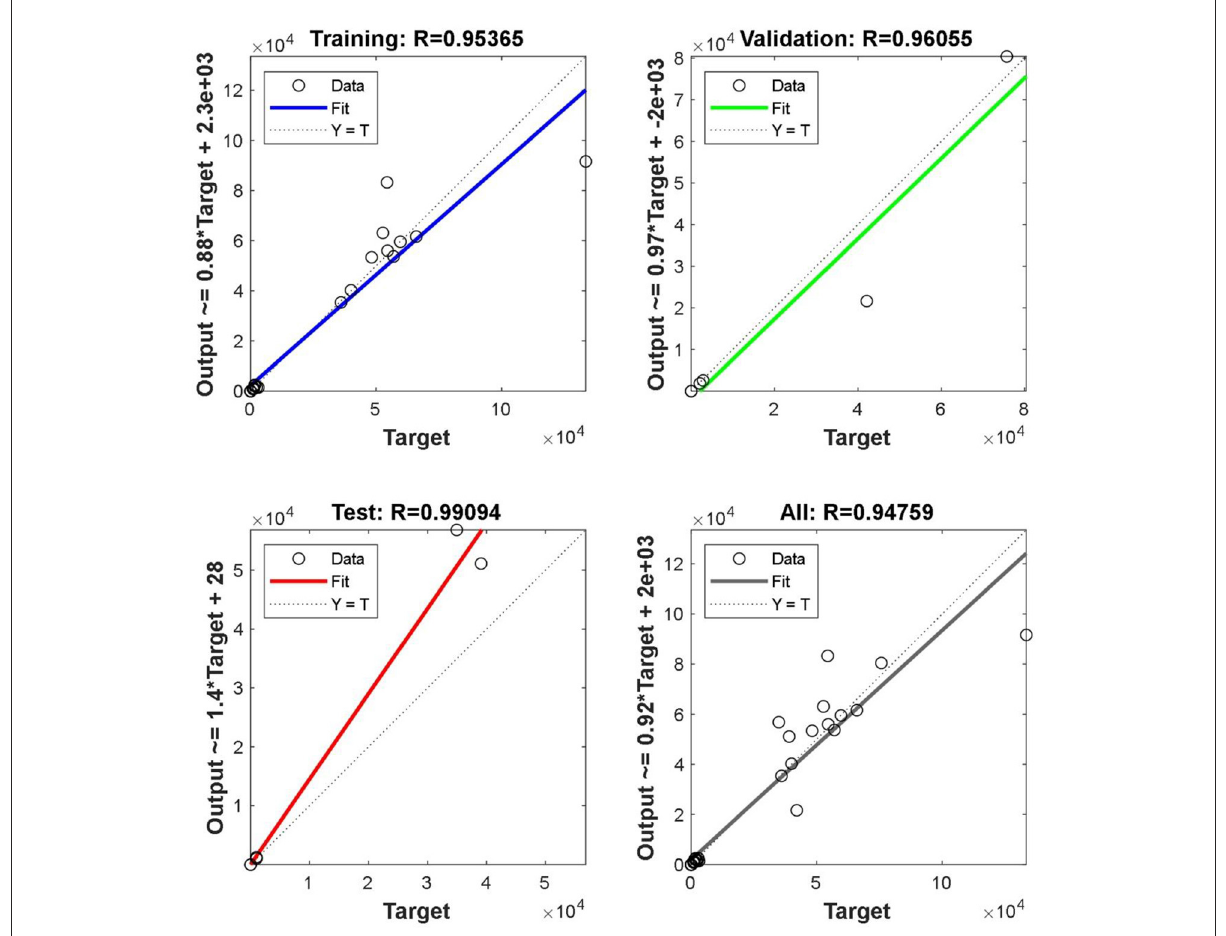
FIGURE9 Correlation coefficient of each sample